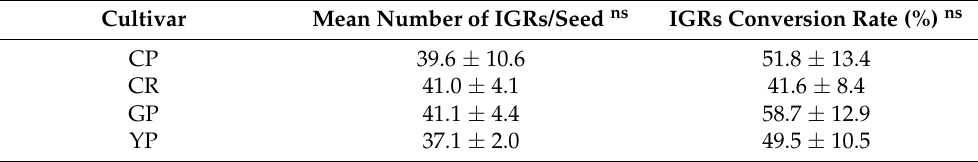
Values represent the mean ± standards error of three independent experiments. ns : non-significant, as determined by ANOVA. CP, Chunpoong; CR, Cheonryang; GP, Gumpoong; YP, Yunpoong. IGR, in vitro grown root.